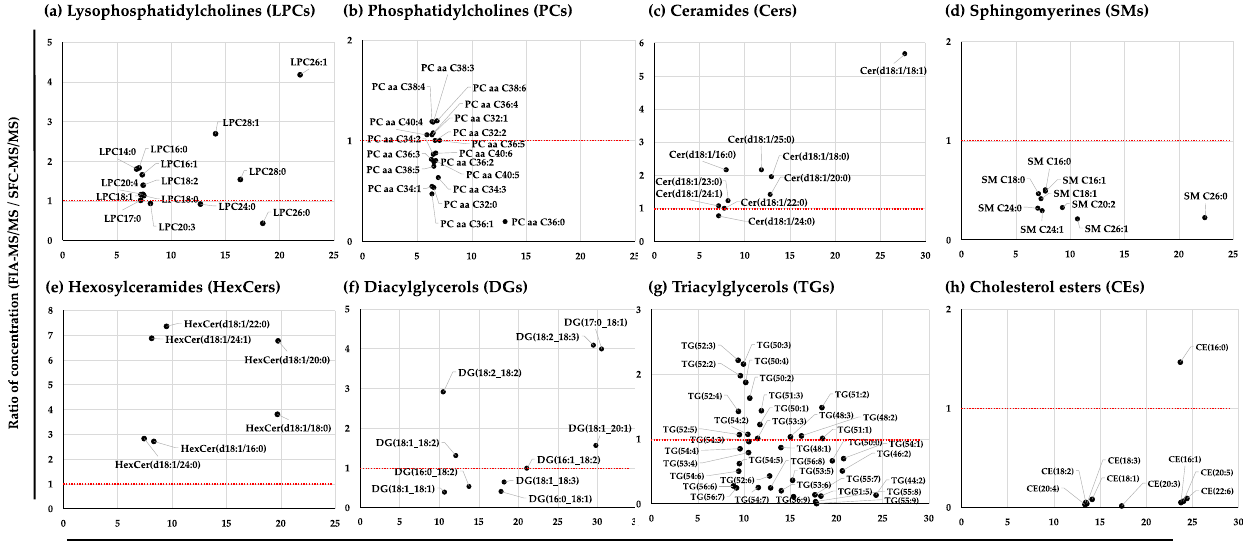
Figure 4. Correlation plots of lipid species in the NIST plasma samples detected by SFC-MS/MS and FIA-MS/MS. ( a ) Lysophosphatidylcholines (LPCs); ( b ) phosphatidylcholines (PCs); ( c ) ceramides (Cers); ( d ) sphingomyelins (SMs); ( e ) hexosylceramides (HexCers); ( f ) diacylglycerols (DGs); ( g ) triacylglycerols (TGs); and ( h ) cholesterol esters (CEs). Metabolites were selected with a CV < 30% from 33 NIST plasma samples detected with FIA-MS/MS. The correlation of concentrations was calculated by the ratio between the mean values of 33 NIST plasma samples detected by FIA-MS/MS and the mean values of 5 NIST plasma samples detected by SFC-MS/MS. The red dotted line shows the 1.0 correlation of the ratio.